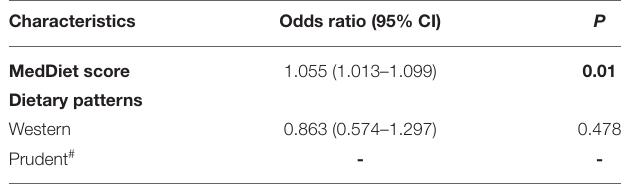
Multiple logistic regression for the odds of being non infected by COVID-19. # Reference category. Bold values indicate a significant